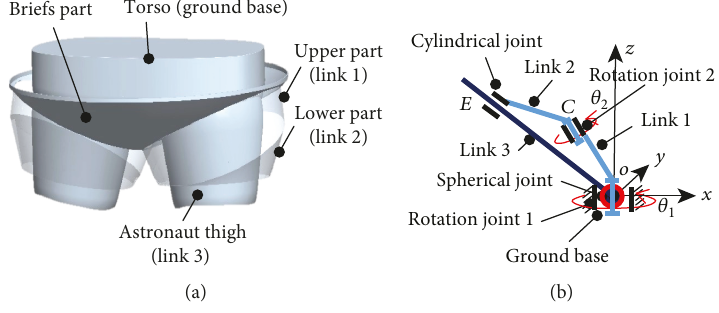
Figure 4: Models of (a) hip joint assembly (b) 3-linkage coupling mechanism.